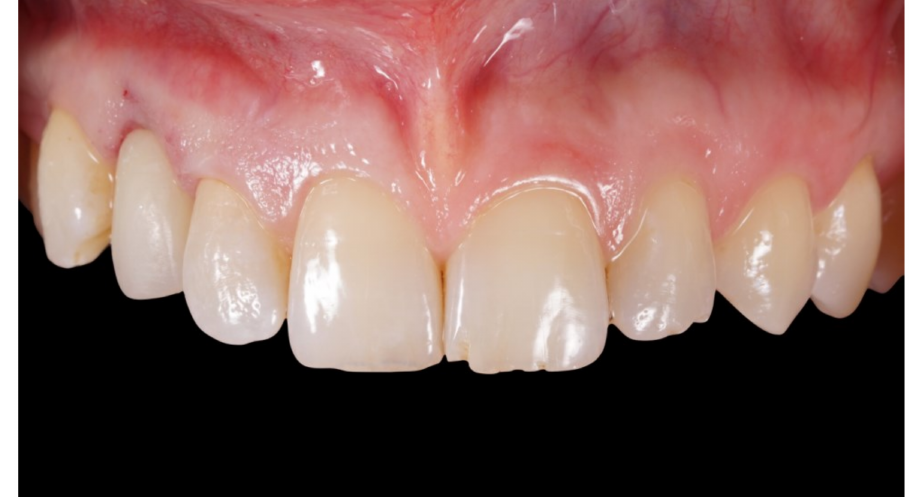
Figure 4. Immediate temporization of immediately placed